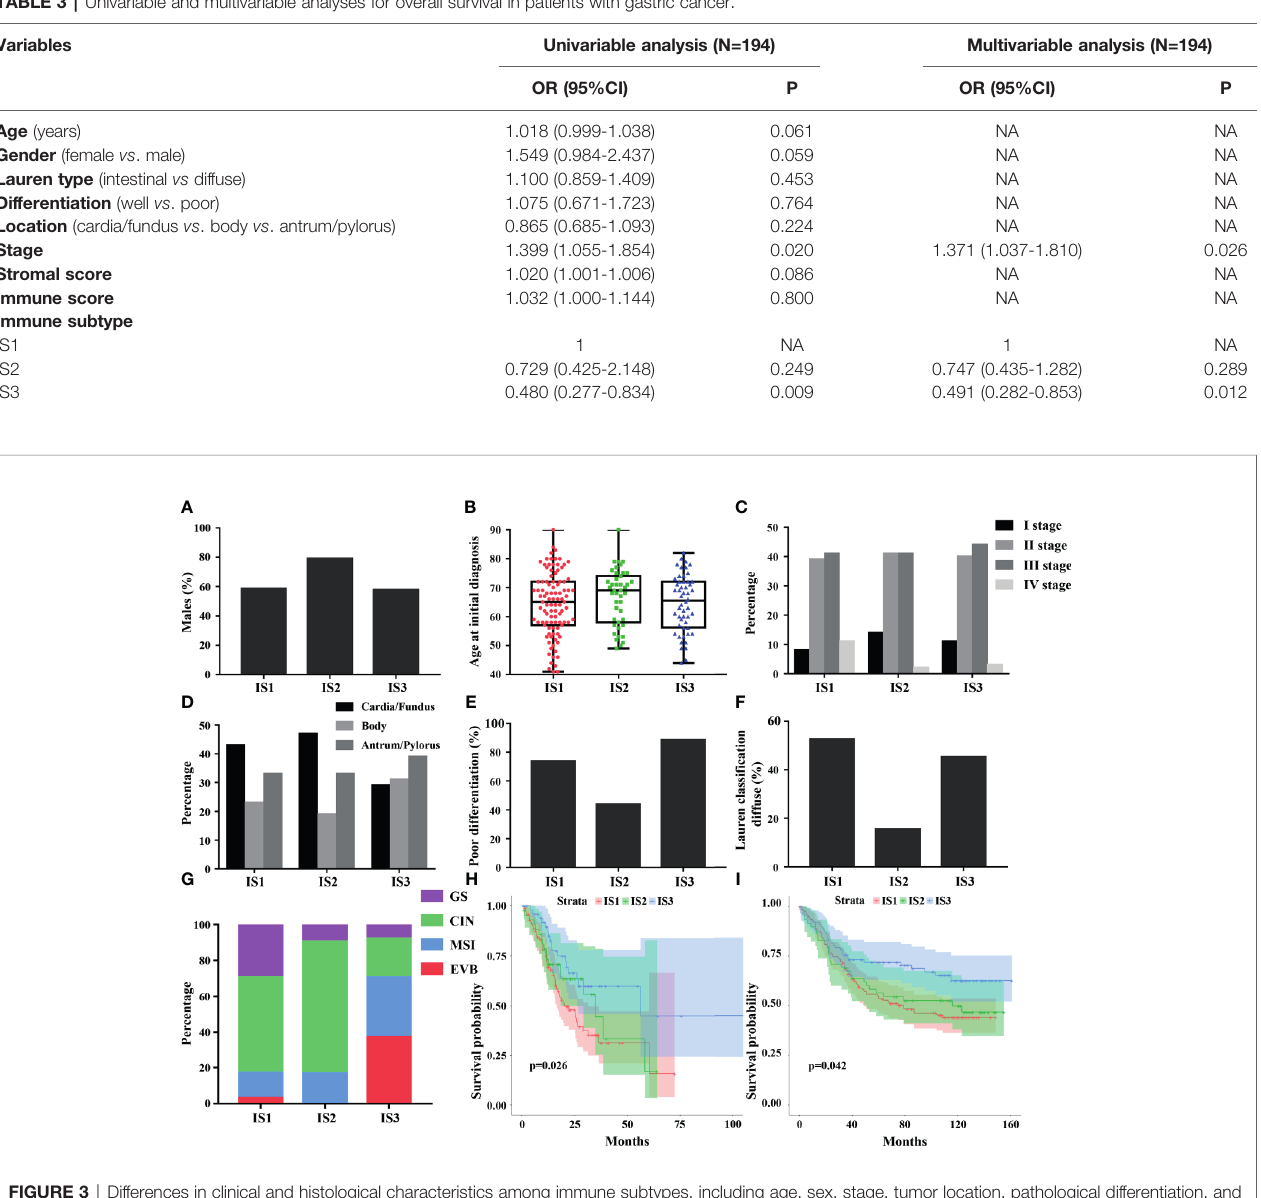
FIGURE 3 | Differences in clinical and histological characteristics among immune subtypes, including age, sex, stage, tumor location, pathological differentiation, and Lauren classi fi cation (A – F) . The plot of patient age at initial diagnosis shows the median, 25th and 75th percentile values (horizontal bar, bottom, and top bounds of the box), and the highest and lowest values (top and bottom whiskers, respectively). The distribution of TCGA molecular subtyping among immune subtypes (G) . The prognostic value of the immune subtypes in TCGA (H) and GEO (I) , indicating best prognosis of IS3.